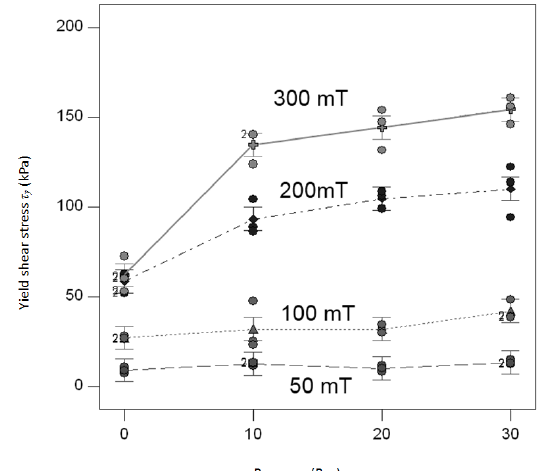
Figure 8: Error bars and experimental yield shear stress for the considered pressure (along the x-axis) and magnetic field levels, 50mT (dashed line), 100 mT (dotted line), 200 mT (dot-dashed line) and 300 mT (solid